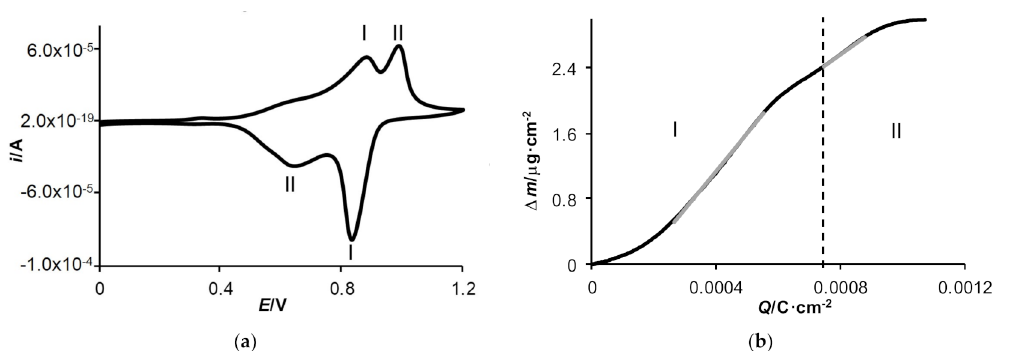
Figure 4. Poly [Ni(salcn(Bu))] (1 electropolymerization cycle) in TBAClO 4 /CH 2 Cl 2 , Pt/quarzglas, v = 0.05 V · s − 1 , vs. Ag/AgCl; ( a ) cyclic voltammogram; ( b ) plot ∆ m vs. Q for anodic process; grey parts of the curve—trend lines for the ∆ m = f( Q ) relationship. I and II—peaks